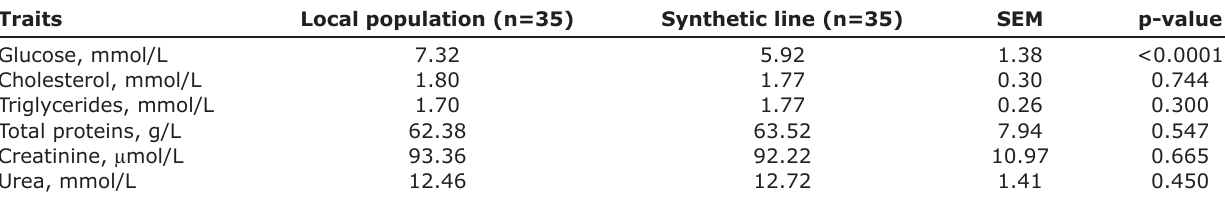
Table-5: Plasma values of biochemical parameters in local population and synthetic line.